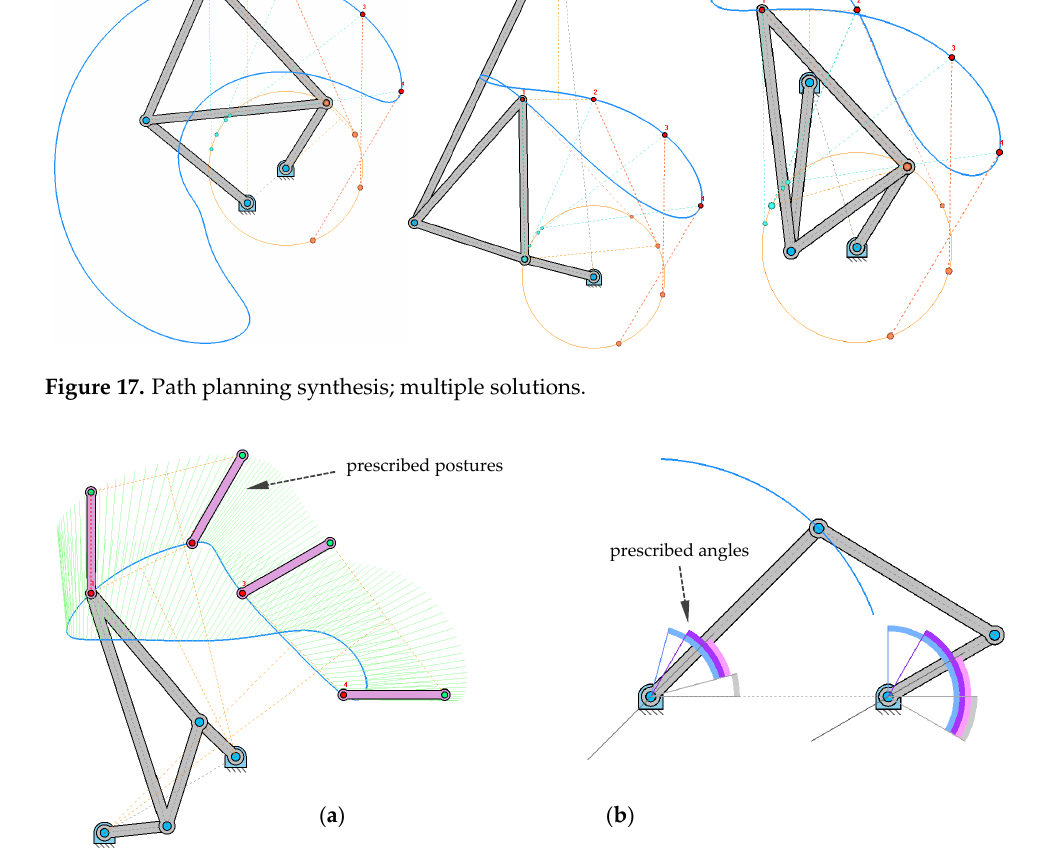
Figure 18. Rigid body motion ( a ) and function generation ( b ) synthesis.